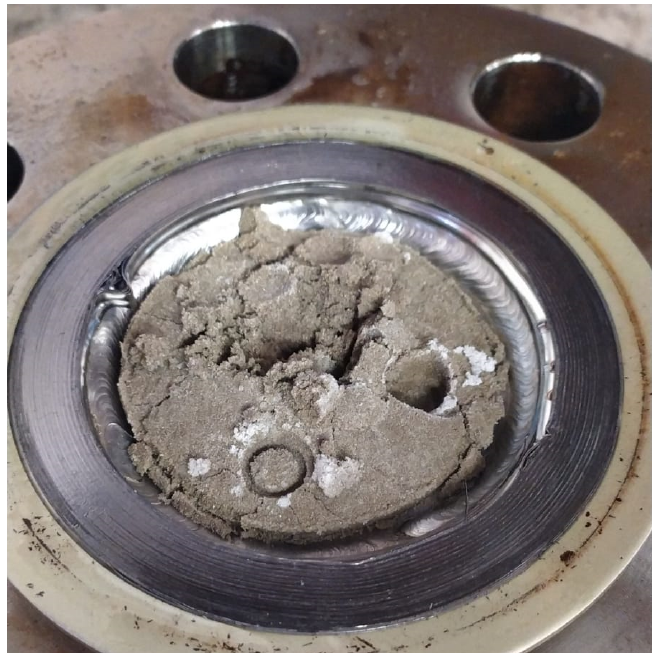
Figure 13. As soon as the test with 30.66 wt.% CuSn12 powder finished, the reactor was opened, and the medium was found to be much more compact than in the absence of powder.